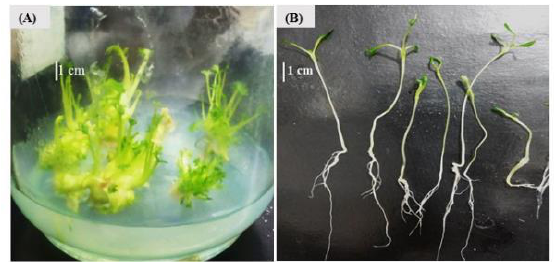
Figure 1. Plant regeneration of Carum copticum. ( A ) Shoot development from callus on MS medium supplemented with 0.25 mg L −1 2,4-D and 1.5 mg L −1 BAP. ( B ) Root development on regenerated shoots after 4 weeks on MS medium supplemented by 1 mg L −1 IAA. Sidebar in the picture shows 1 cm. Table 3. Effect of different concentrations of 2,4-D and BAP on shoot regeneration from Carum copticum callus on MS medium.